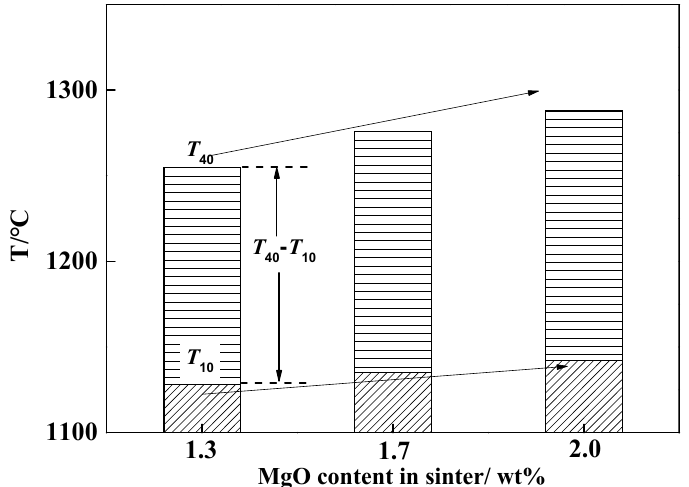
Figure 7. T 10 , T 40 and softening zone for di ff erent MgO content sinter.